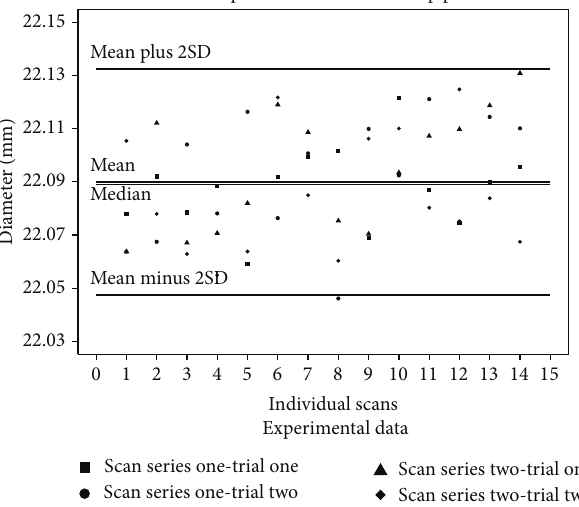
Figure 6: The values of the femoral component head diameters obtained from each individual calculation are shown with the median, mean, and two SD lines drawn through the data. The median value is quite close to the mean value.